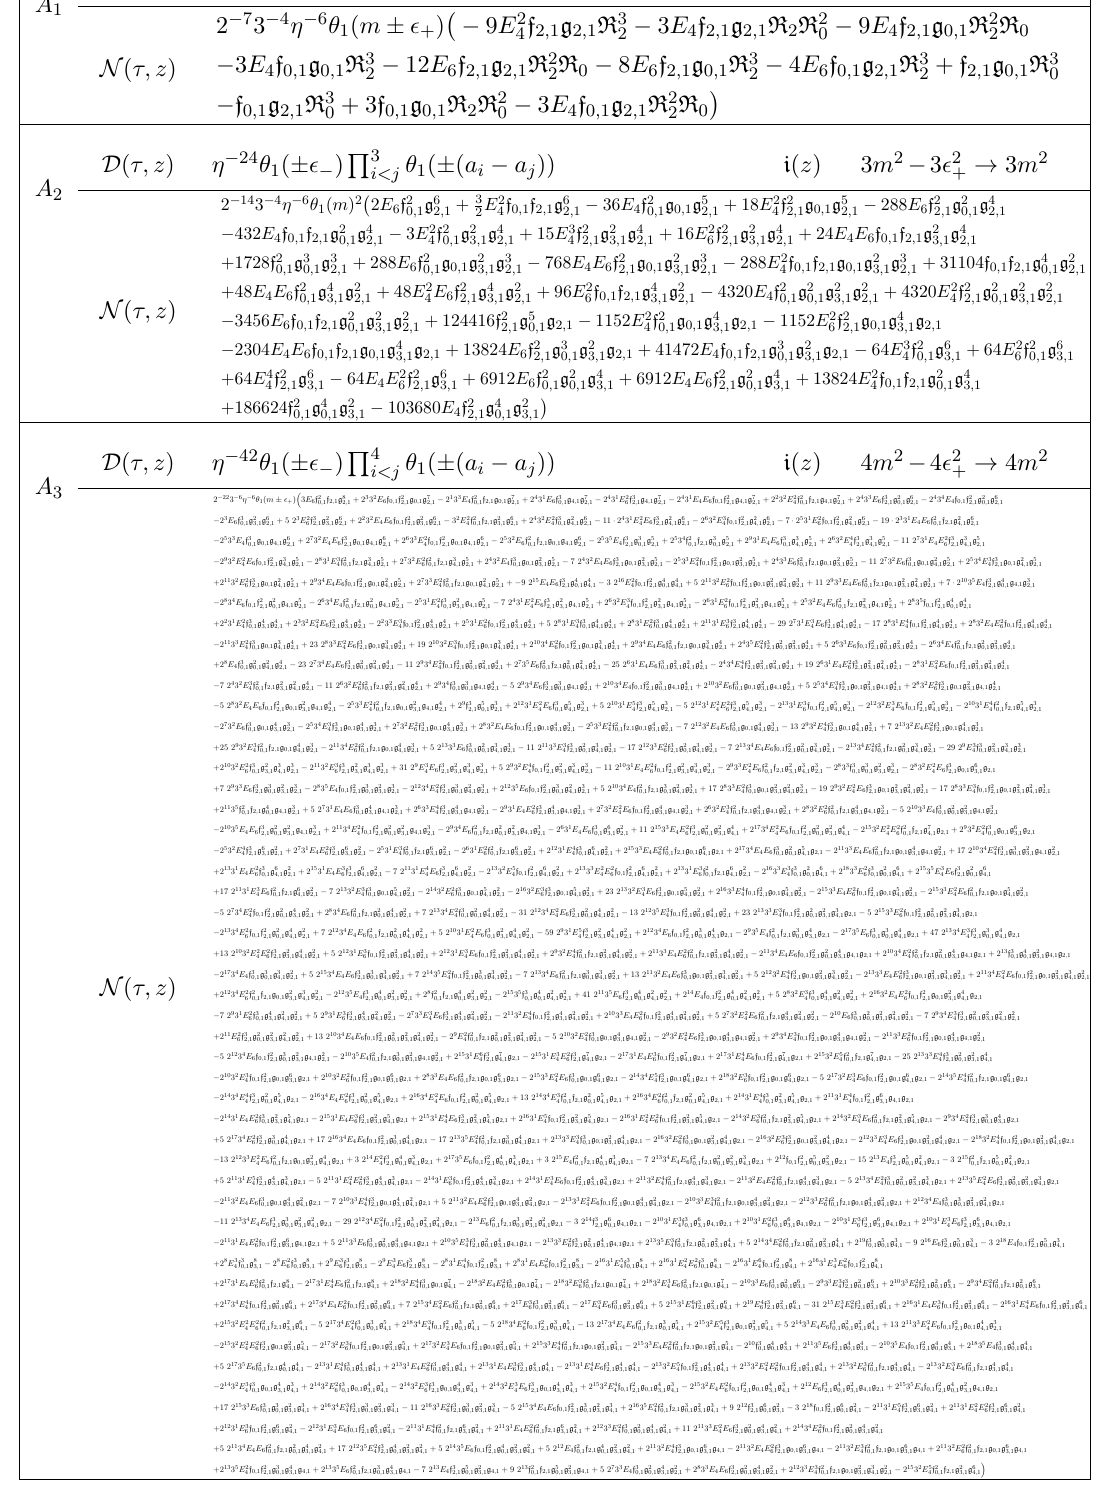
with all k i (cid:20) 1. f k 1 ; (cid:1)(cid:1)(cid:1) ;k n g